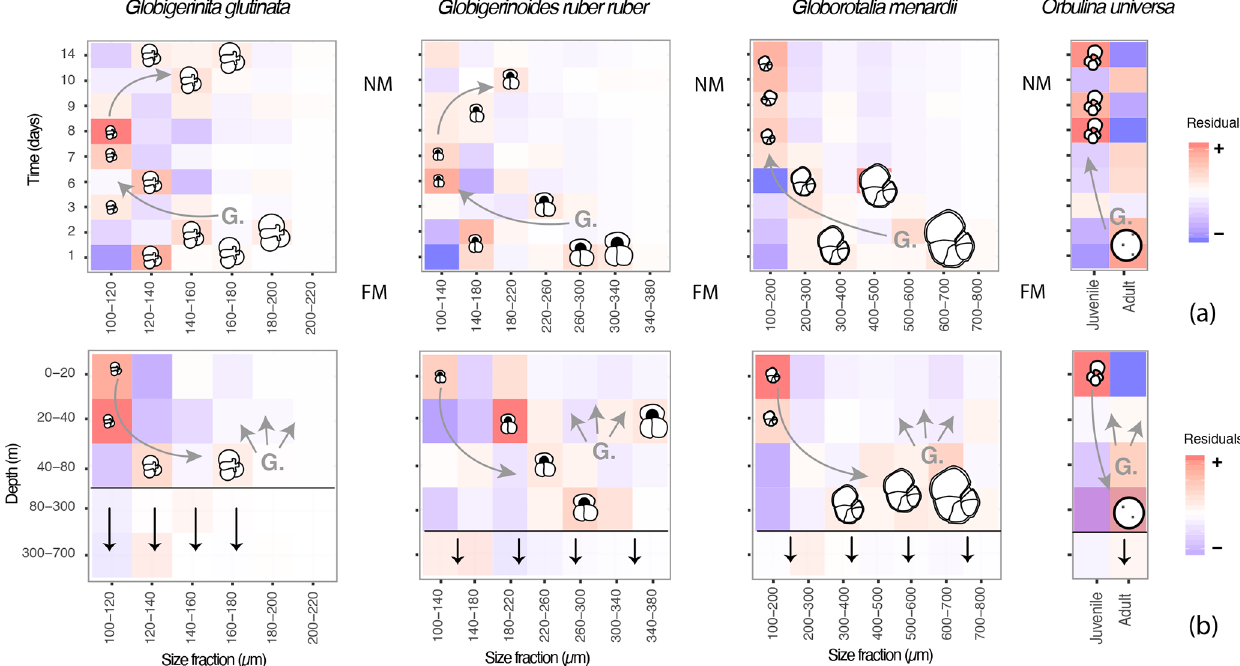
Figure 7. A model describing the canonical ontogenetic trajectory of G. glutinata , G. ruber ruber , G. menardii and O. universa as recorded in the studied material. The residuals (further discussed in 2.3 and 3.4) highlight size classes that are overrepresented (red tones, “ + ”) or underrepresented (blue tones, “–”) across time (a) , with FM meaning full moon and NM meaning new moon, and depth (b) in comparison to the whole dataset. Every coloured square indicates the presence of specimens and shows that foraminifera of all sizes were collected at almost all depths and times throughout the survey. Based on our observations the horizontal black lines in (b) represent the depth from which > 50% of specimens are dead, and the vertical black arrows illustrate the flux of empty shells. Based on our interpretations (see results and discussion) “G.” in both panels hypothesises gametogenesis and the presence of gametes followed by gamete dispersions (associated grey arrows). The curved grey arrows highlight the hypothetical ontogenetic trajectories of specimens (gametes to reproductive stage) across time and